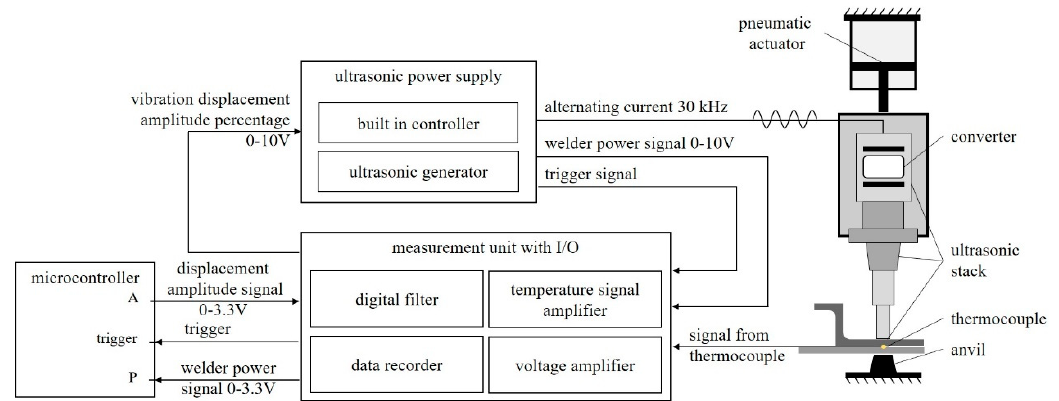
Figure 3. A schematic representation of the welder, the data recording, and the control system.